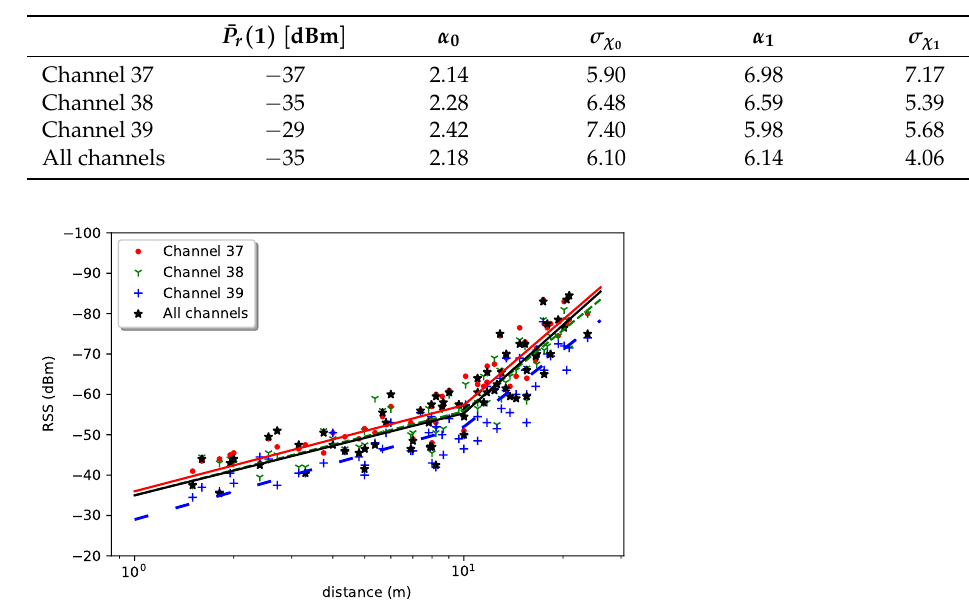
Figure 15. Two-segment path loss models derived using median of six random data samples from only one receiver. Table 2. Two-segment path loss model parameter values derived using median of six random data samples from only one receiver.